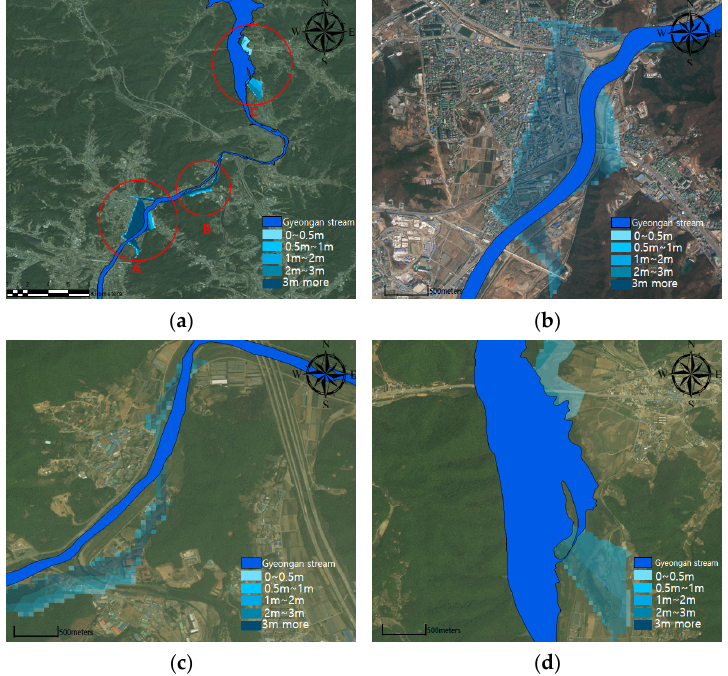
Figure 8. Flood inundation maps for a mega flood: ( a ) flood inundation map for a mega flood in the Gyeongan stream basin; ( b ) flood inundation map at area A in ( a ); ( c ) flood inundation map at area B in ( a ); ( d ) flood inundation map at area C in ( a ). Then, we overlaid the flood inundation map for the mega flood with the administrative district map of the Gyeongan stream basin to identify the administrative districts that would be inundated by the mega flood (Figure 9).